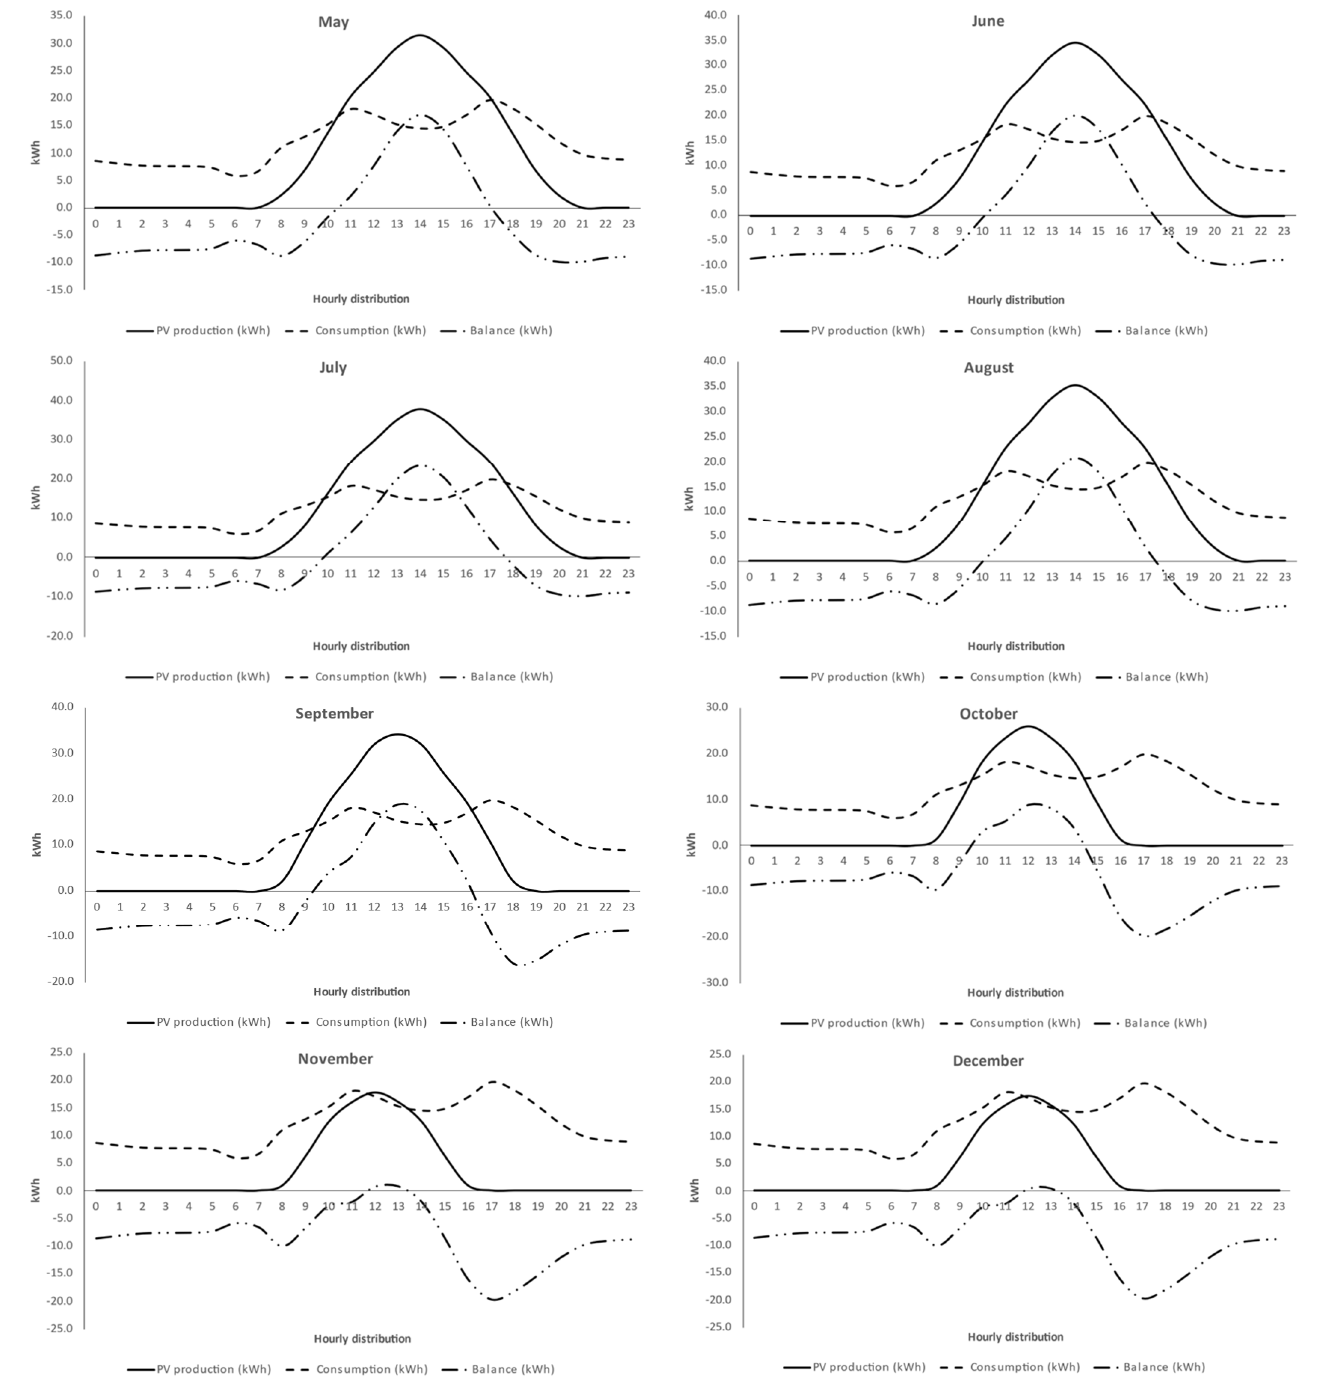
Figure 7. Distribution of production, consumption, and average monthly balance on an hourly basis.